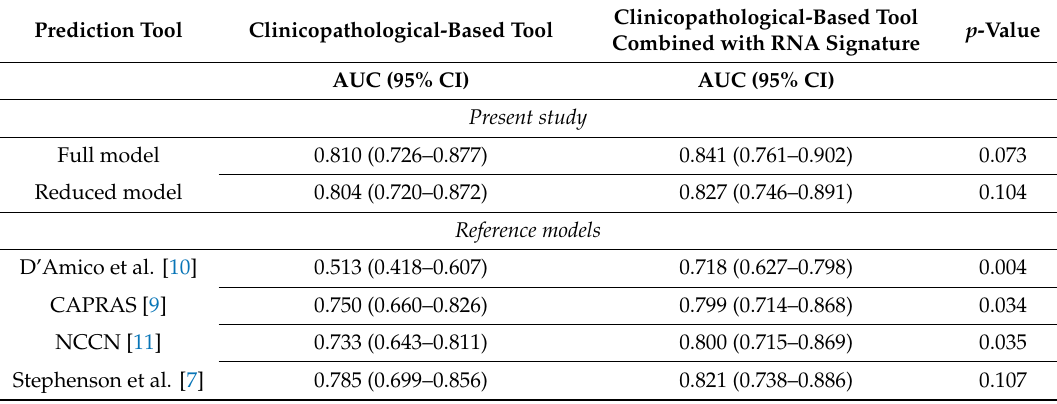
Table 9. Improvedprediction ofbiochemicalrecurrenceafterradical prostatectomyusing clinicopathological- based tools in combination with the RNA